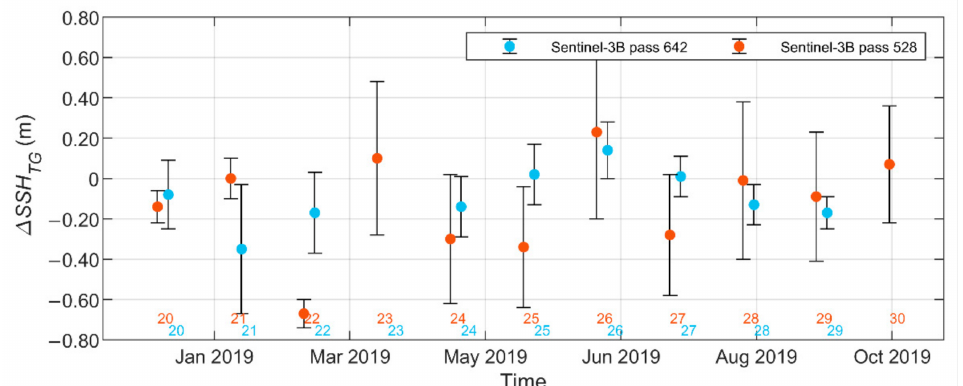
Figure 9. Residual di ff erences ( ∆ SSH TG ) between the sea surface height of Sentinel-3 ( SSH SA ) and geoid-based water surface height ( SSH TG ) in Lake Peipus (blue dots) and Lake V õ rtsjärv (red dots). The zero line denotes the reference SSH TG . Coloured numbers indicate the cycle’s number. Vertical bars represent the ± 1 σ standard deviations.